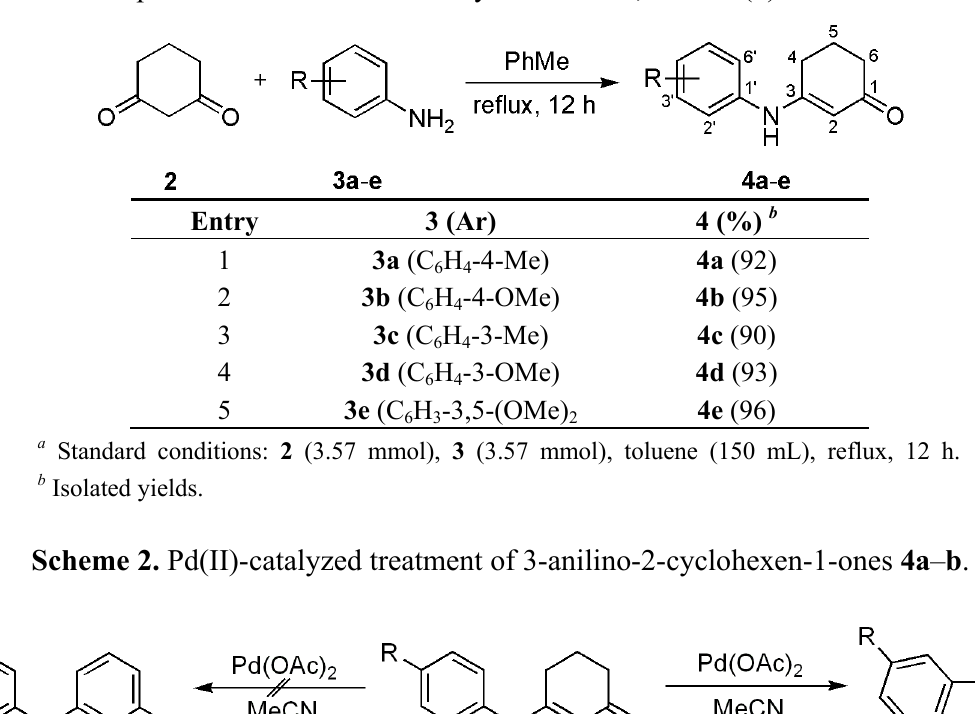
Table 1. Scope of the reaction between cyclohexane-1,3-dione ( 2 ) and anilines 3a – e a